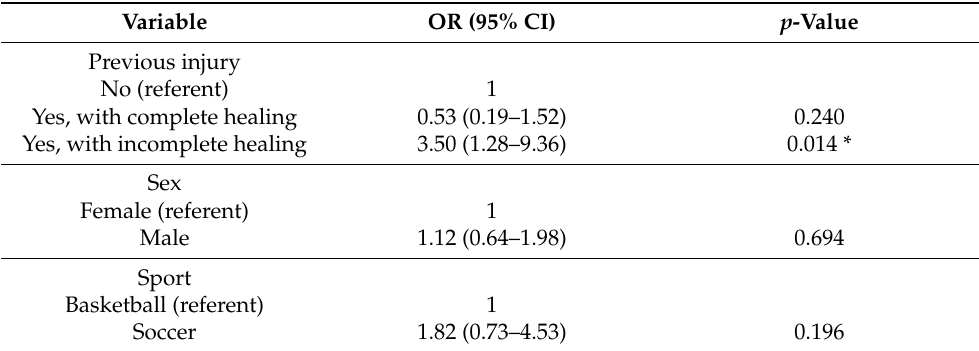
Table 3. Multivariable logistic regression model examining the variables associated with preseason musculoskeletal pain in collegiate soccer and basketball players. Variable OR (95%